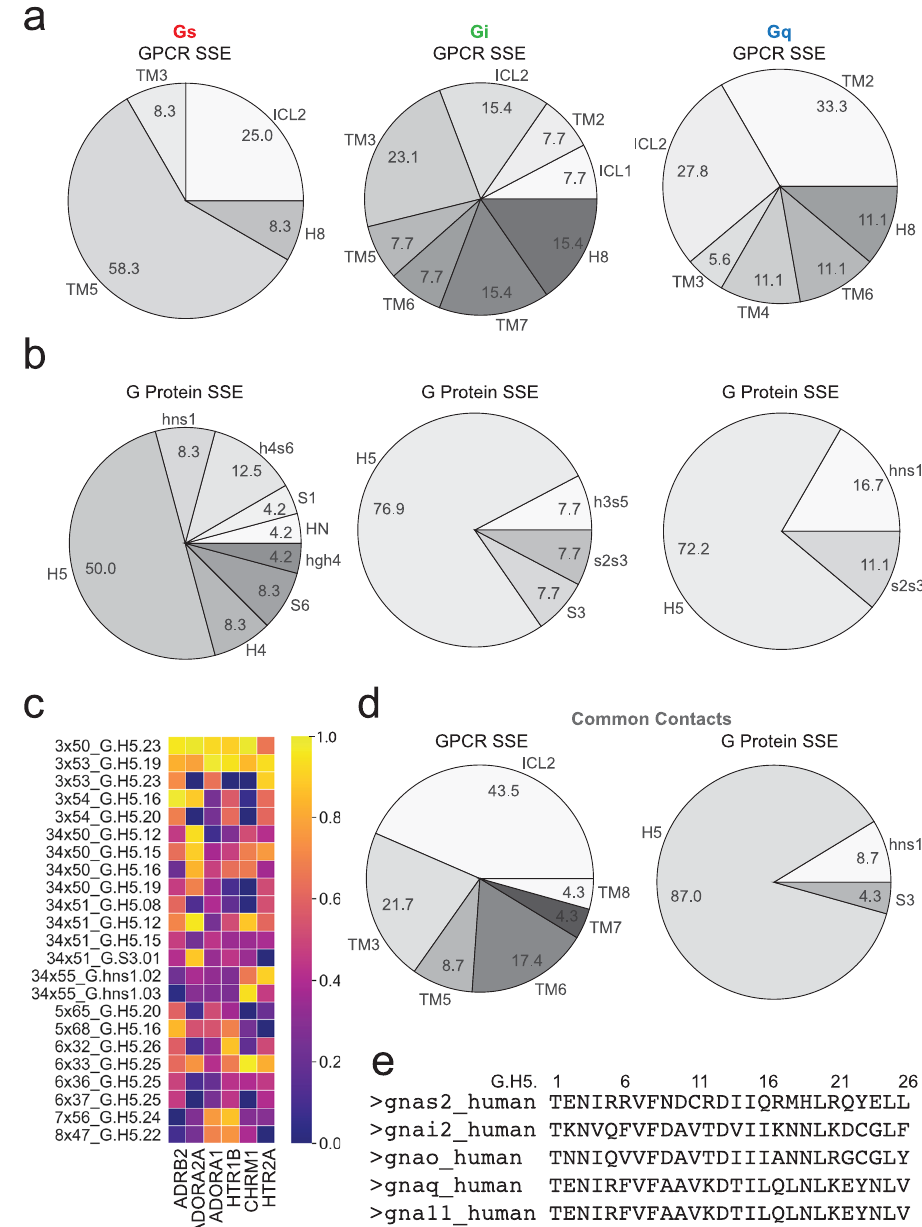
Fig.3|UniquesignaturesofGPCRandGproteinstructuralregionsinvolvedin contacts from different G protein families. The location of the G protein family “ speci fi ccontacts ” mappedtothevariousGPCRandGproteinsecondarystructural elements (SSE). Source data for all plots are provided as Supplementary Data 2. a The percentage of GPCR:G protein contacts speci fi c to the Gs (left), Gi (center), andGq(right)interactionarisingfromeachSSEoftheGPCRisshown. b Similarpie chart displaying the percentage of contacts from speci fi c SSEs of the G proteins.